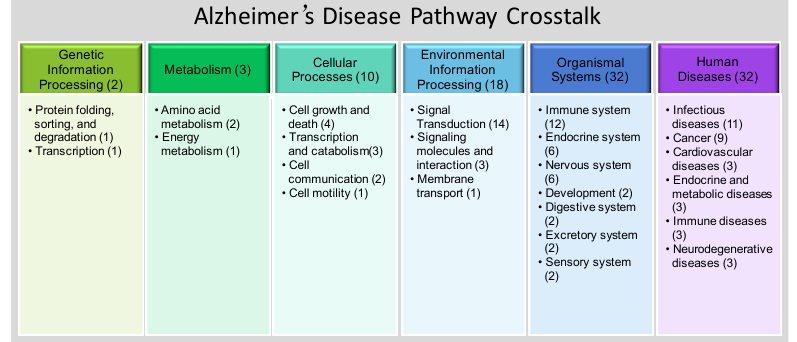
Figure 4. Pathways found to have significant crosstalk with the AD pathway and corresponding KEGG categories (shown in colored blocks). Specific KEGG pathway types are listed below each category with the number of occurrences in parentheses. NOTE: Although there are seven KEGG pathway categories, here we only show the six KEGG pathway categories that included identified SNP-enriched pathways in this